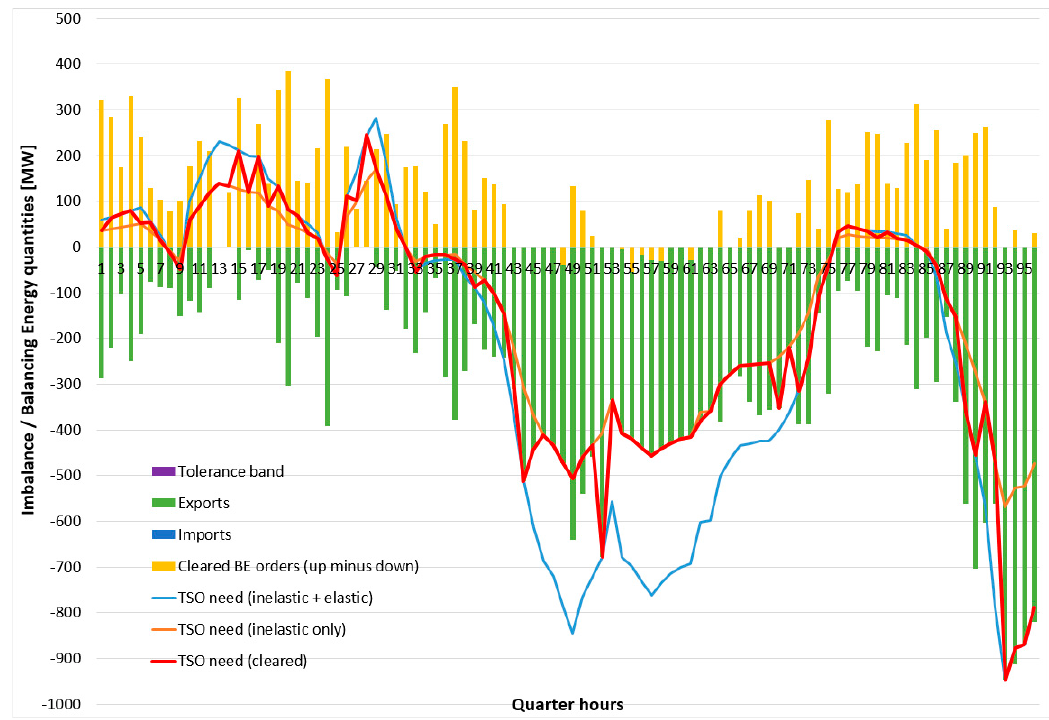
Figure 12. Clearing results per RTU for Spain.